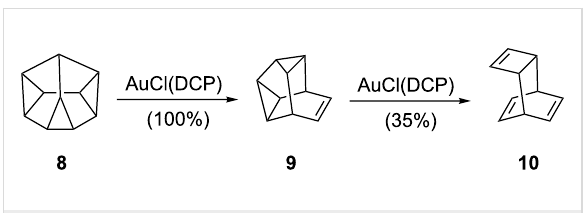
Scheme 2: Gold-catalyzed rearrangements of strained